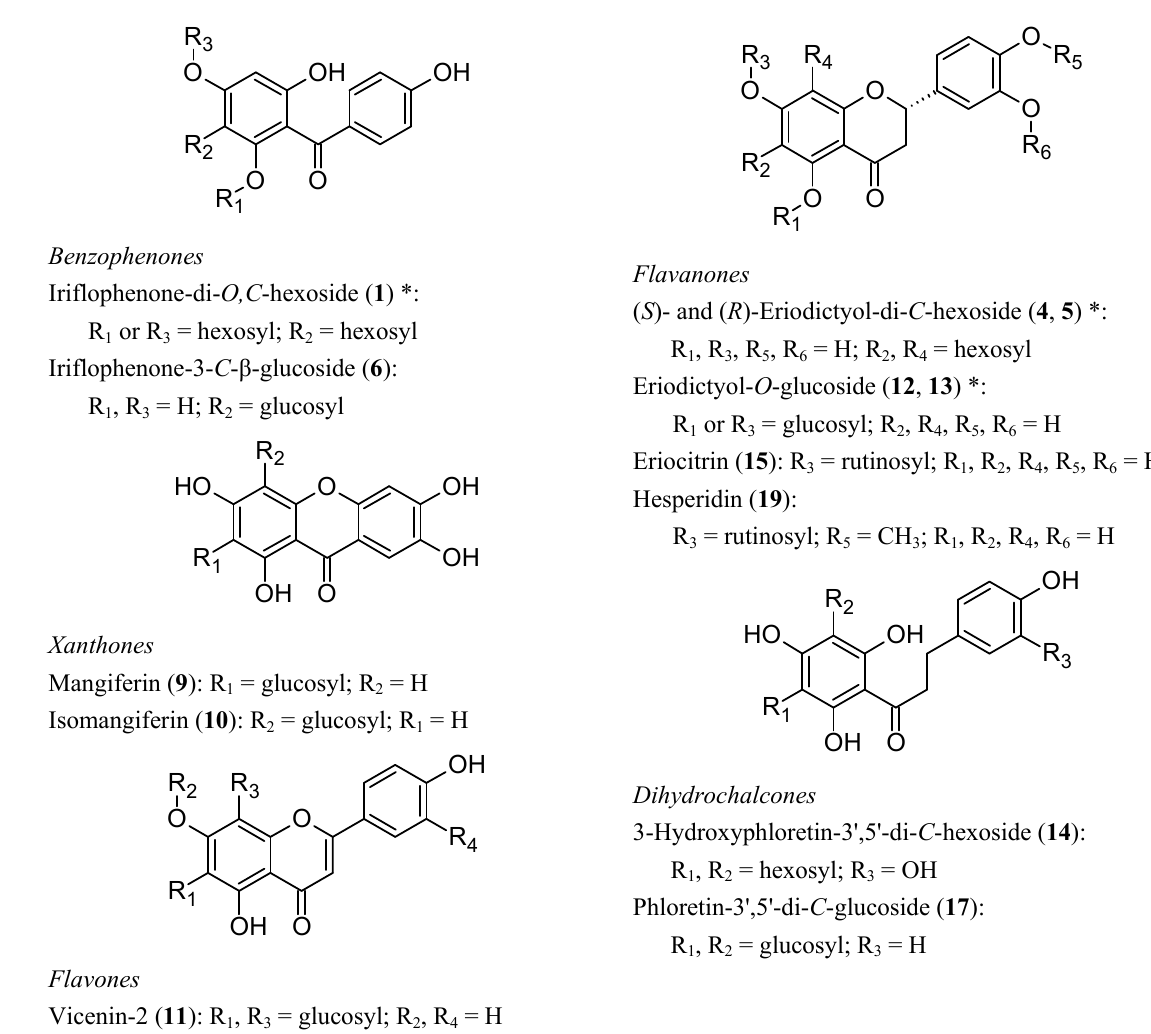
Figure 2. Structures of phenolic compounds identified in freeze-dried aqueous extracts of green and fermented Cyclopia subternata (* indicates that the position of glycoside moieties are not